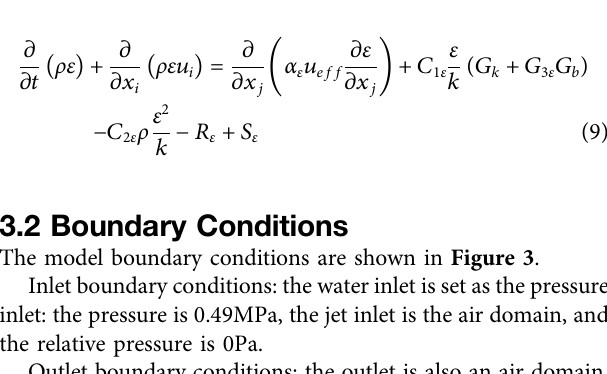
FIGURE 5 | Coordinate system and monitoring surface layout.